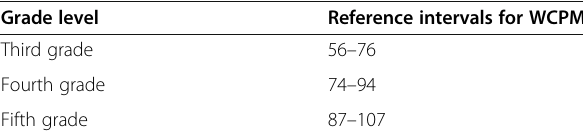
Table 2 WCPM reference ranges according to student